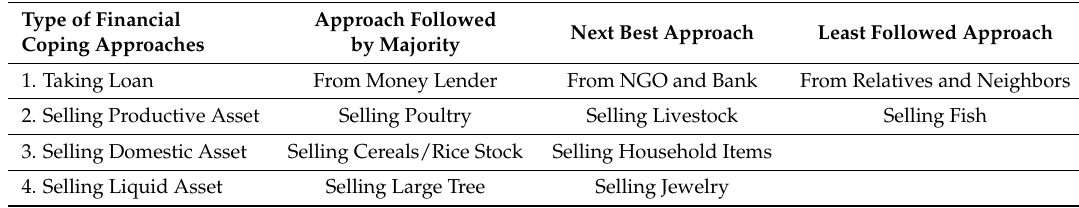
Table 3. Approaches followed to financially cope.